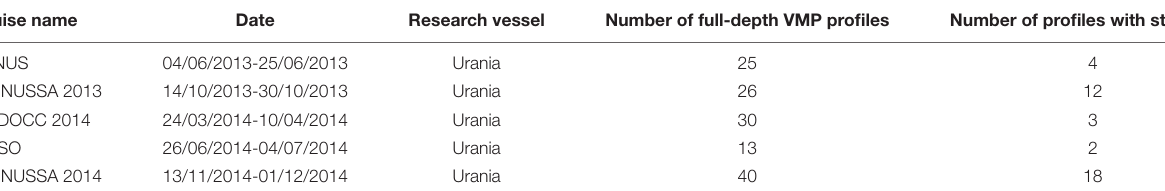
TABLE 1 | Oceanographic cruises that contributed to the microstructure data set used in this study (R/V URANIA).